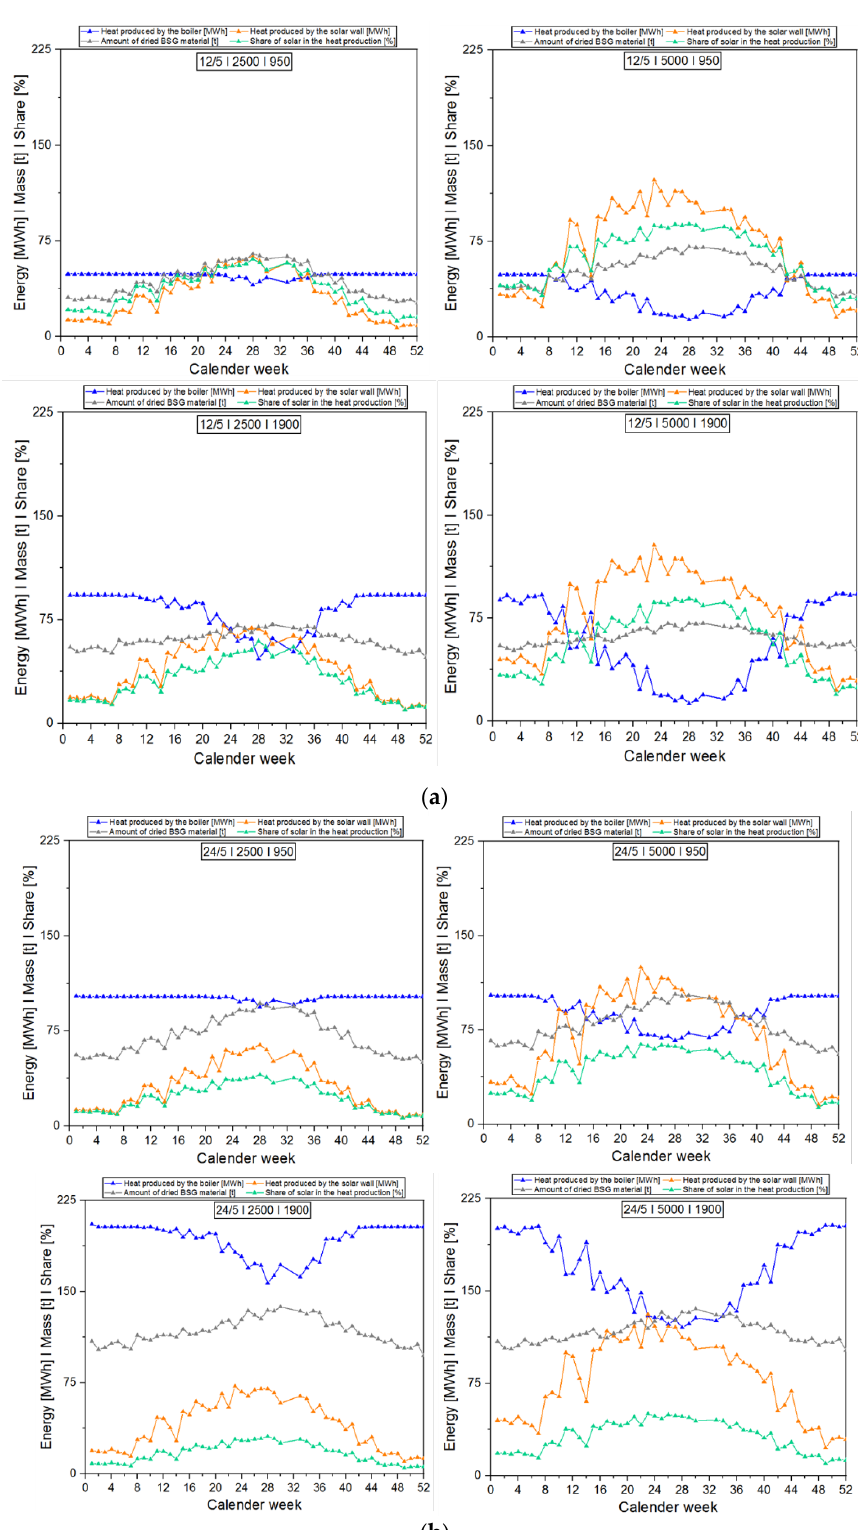
Figure 7. Heat production per calendar week from both renewable heat sources with varying capacities as well as operational strategies ( a ) 12/5 and ( b ) 24/5 (top left—reference design, top right—doubled SW area, bottom left—doubled boiler capacity, and bottom right—doubling of both heat sources).